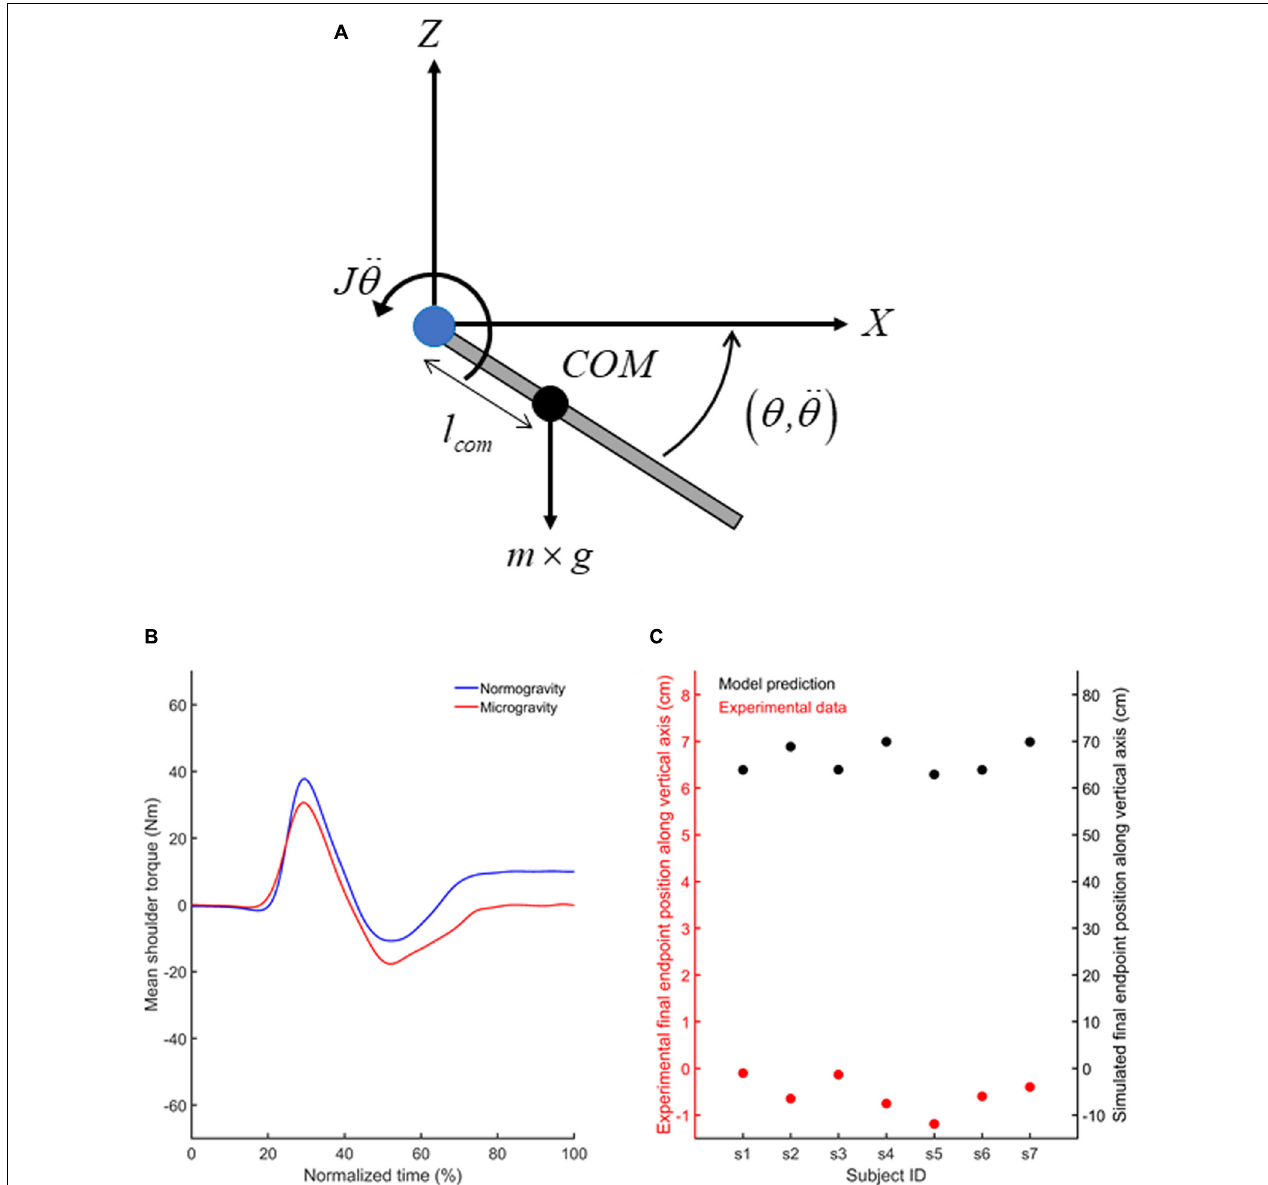
FIGURE 7 | (A) Free body diagram of the extended upper limb showing the location of the upper limb center of mass (COM; black circle) and the lever arm ( l com ) of the COMwith respect to the shoulder joint (blue circle). Also illustrated are the gravitational force ( m × g ) acting at the center of mass of the upper limb and the inertial torque (w). Summation of torques with respect to the shoulder joint leads to Eq. 1 provided in the text. (B) Mean shoulder torques computed using the inverse dynamical model for movement directed toward T1 in normogravity and microgravity. (C) Mean vertical finger endpoint position shown by each participant (red circles) when reaching toward T1 in microgravity (left y axis) and endpoint positions predicted by the forward dynamic model (black circles) if the participants would have used a 1 g internal model to produce their movements in microgravity (right y axis). Similar results (i.e., shoulder torques and vertical finger endpoint positions) were observed for movements directed toward T2 (not